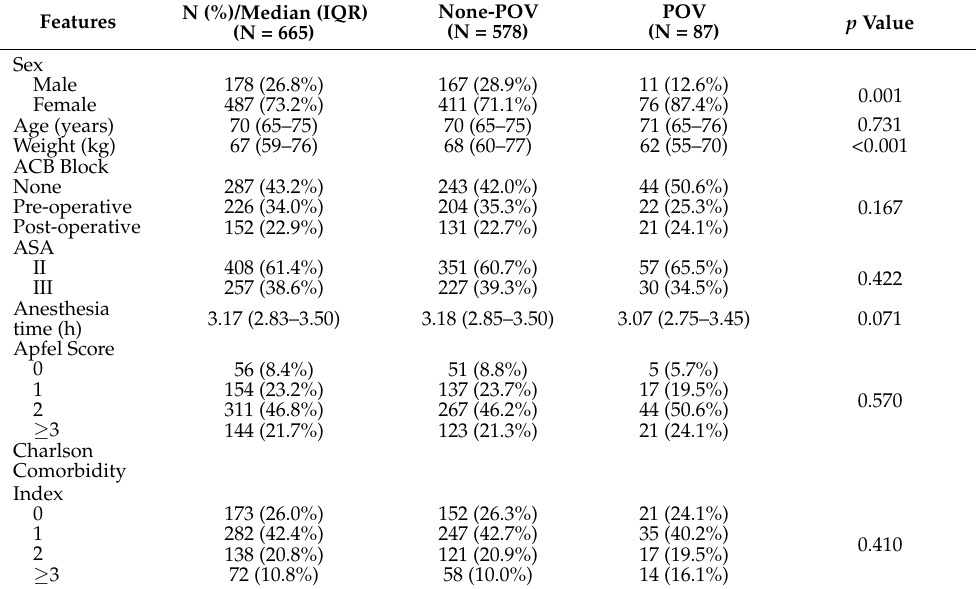
Table 1. Demographic characteristics of 665 patients with or without postoperative vomiting after primary